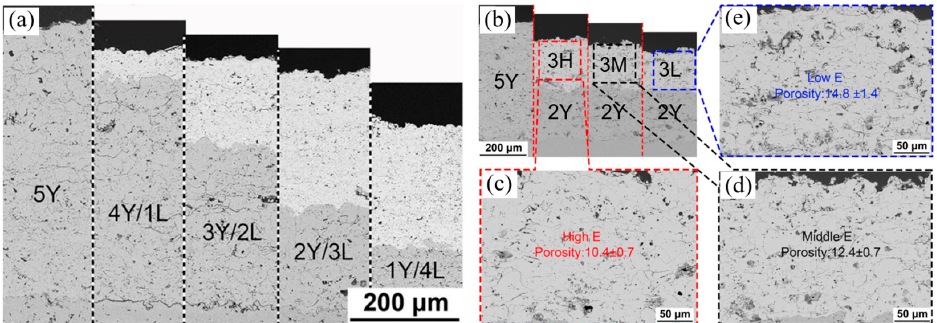
Figure 42. Cross-sectional SEM images of DCL TBCs: ( a ) equivalent thermal insulation with different thickness ratio ( b – e ) equivalent thermal insulation with different modulus [217,218] .